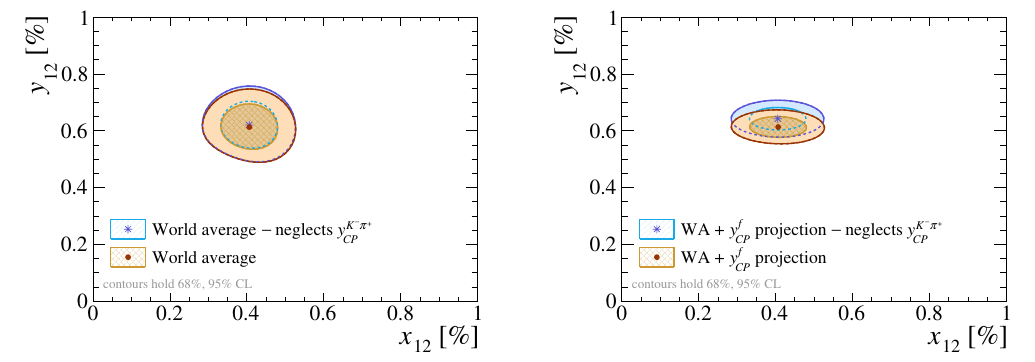
Figure 1 . Impact of neglecting the y K − π + terms in eqs. (4.5a) and (4.8) on the world average of CP the mixing parameters, (left) as of today and (right) after including a new measurement of y f , CP where f equals K + K − or π + π − , with the precision achievable with the D ∗ (2010) + -tagged data sample collected by the LHCb experiment during its Run 2 data taking (2015–2018). In the right plot, the value of y f is fixed to its point estimate based on the results of the fit in ref. [33], and its CP uncertainty is set to 0 . 3 × 10 − 4 . Measurements of the γ angle of the CKM unitary triangle relying on two-body D 0 decays, which improve the precision on the strong-phase ∆ and indirectly K − π + on the current world average of y 12 by around 40% [16], are not included for simplicity. The code employed to perform the fits is available on GitHub